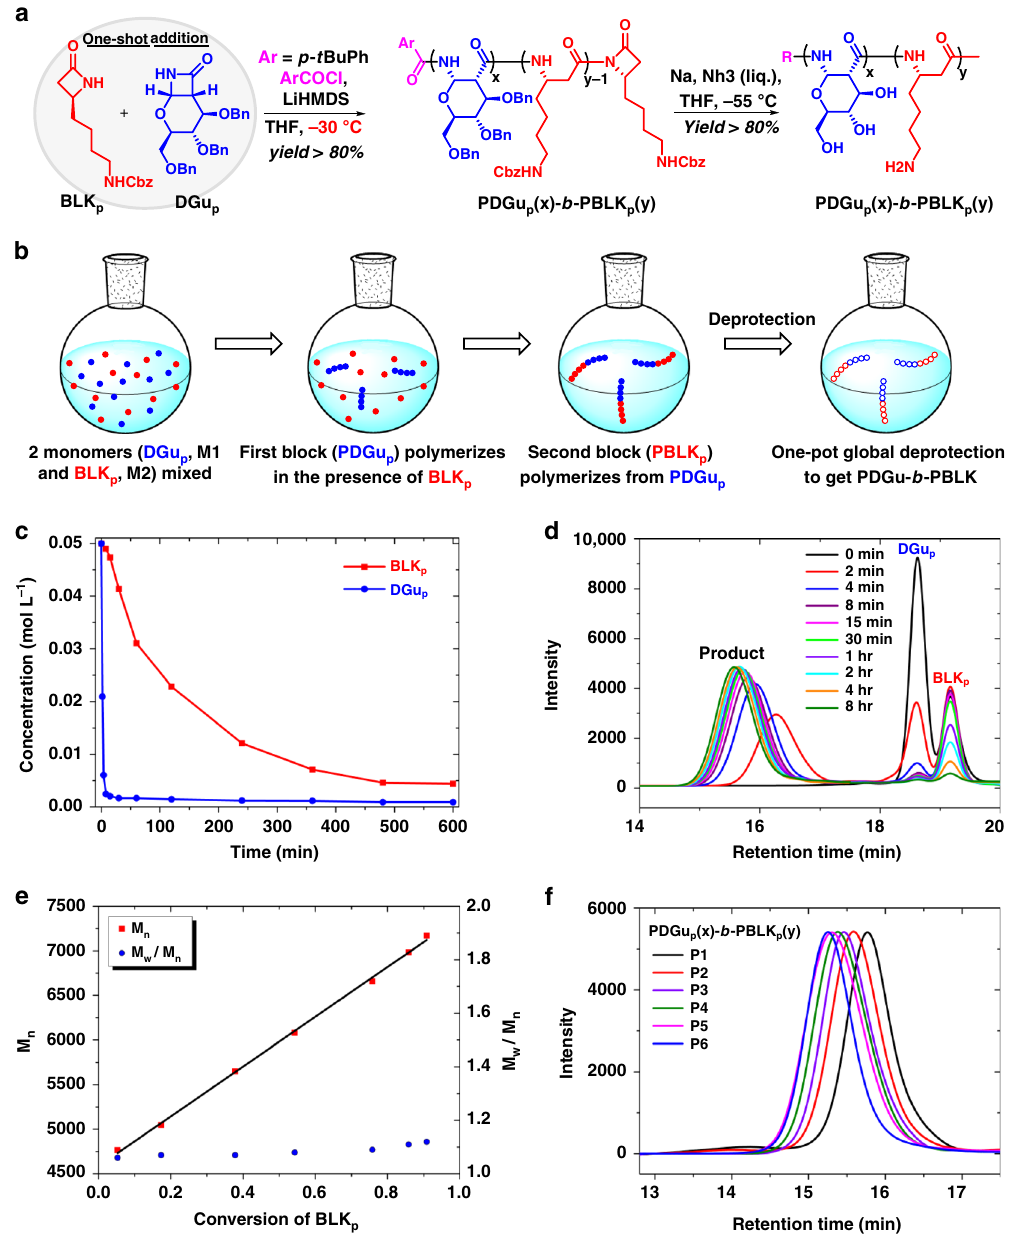
Fig. 1 Facile one-shot one-pot synthesis of PDGu(x)- b -PBLK(y) block copolymer. a Synthetic scheme of PDGu(x)- b -PBLK(y) . b One-shot addition of both monomers ( DGu p and BLK p ) leads to block copolymerization when the monomers have contrasting reactivities. c – e Kinetic studies and f GPC measurements verify the well-controlled single chain block architecture of PDGu p (x)- b -PBLK p (y) . c Remaining monomer concentration vs time. d GPC curves of partially polymerized products at selected quenching times. e Molecular weight (M n ) and molecular weight distribution ( Đ ) as a function of conversion of BLK p . f GPC of protected-(co)polymers